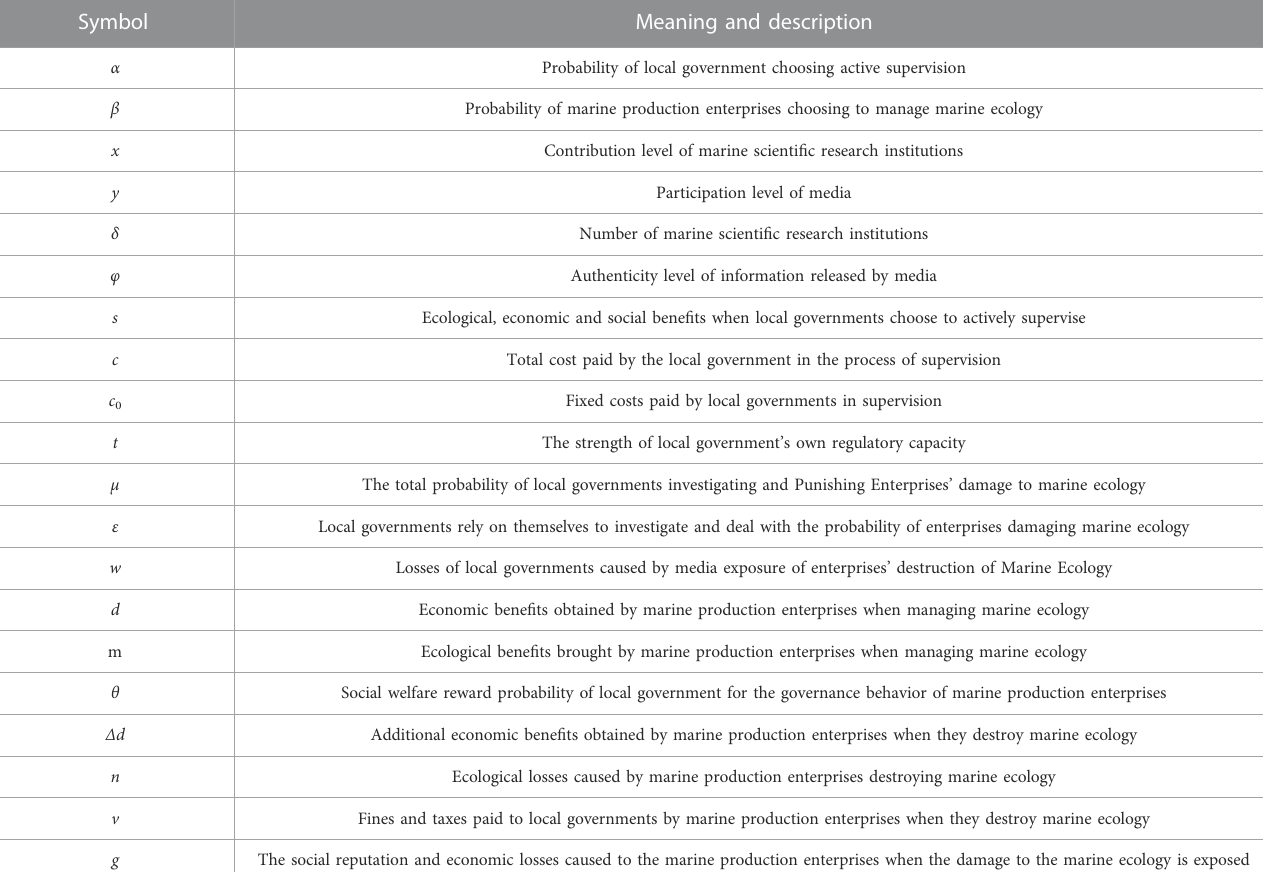
TABLE 2 Symbols and meanings of relevant